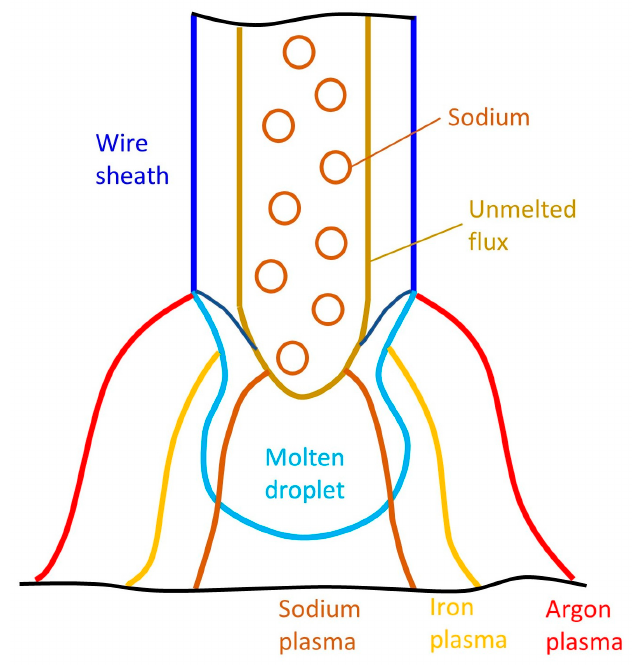
Figure 7. Position of plasma distribution for wire 3.